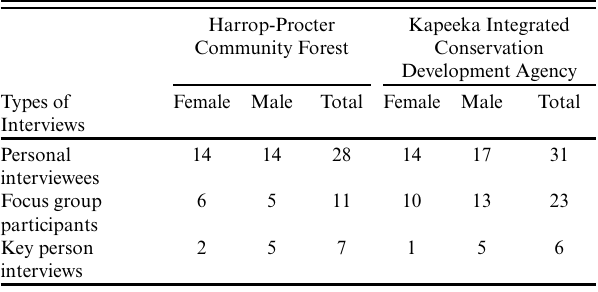
Table 1 . Number of study participants by data collection